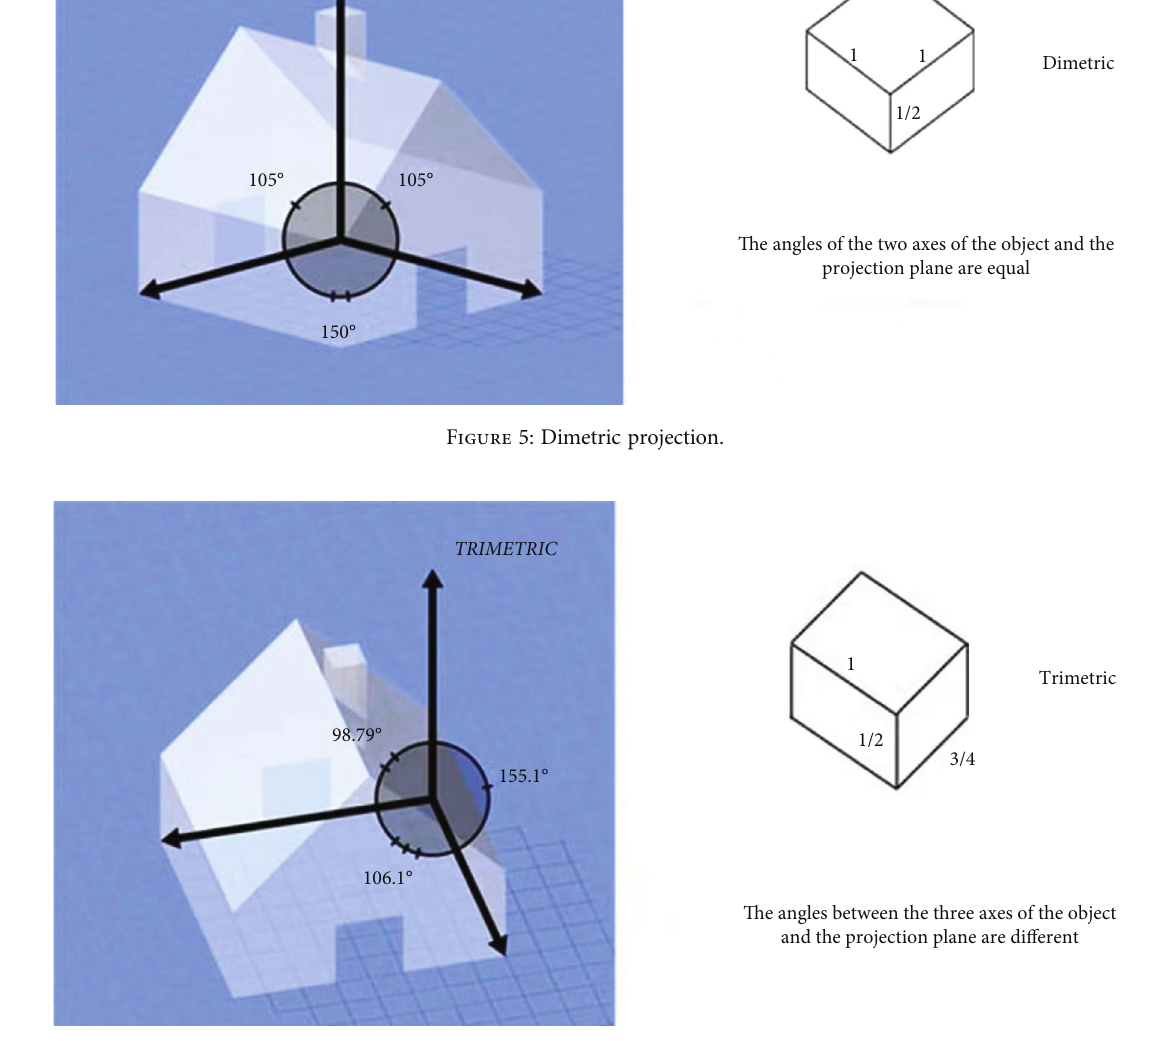
Figure 6: Trimetric